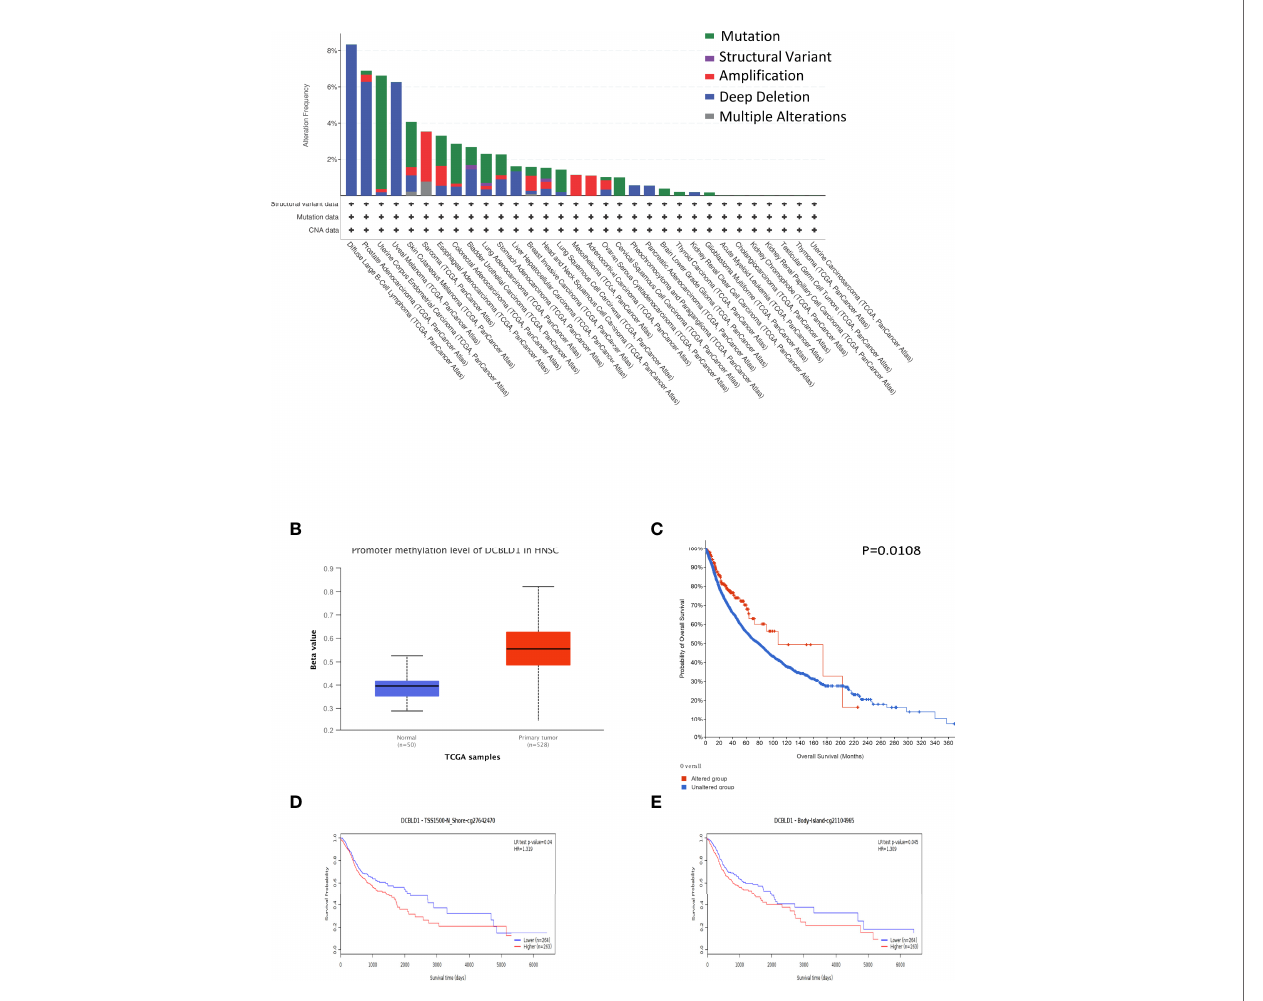
FIGURE 6 | The gene mutation and methylation of DCBLD1 in HNSCC. (A) DCBLD1 mutation in pan-cancer. (B) The methylation level of DCBLD1 in HNSCC. (C) The association of DCBLD1 alteration and overall survival of HNSCC. (D, E) The Kaplan – Meier survival of the promoter methylation of